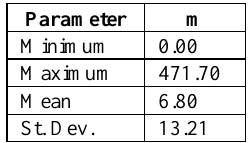
Table 1. Statistical parameters characterising the distribution of the distance between each single FCD position and the nearest road network element